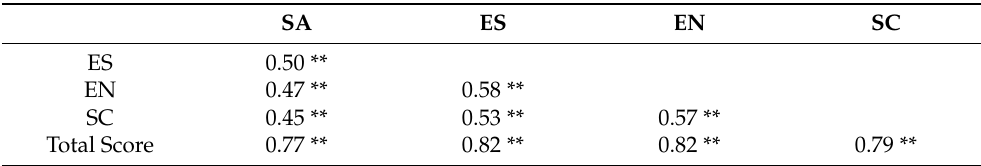
Table 4. Correlation matrix of the total score and subscales of the Resilience Scale for Chinese Children ( N = 374).